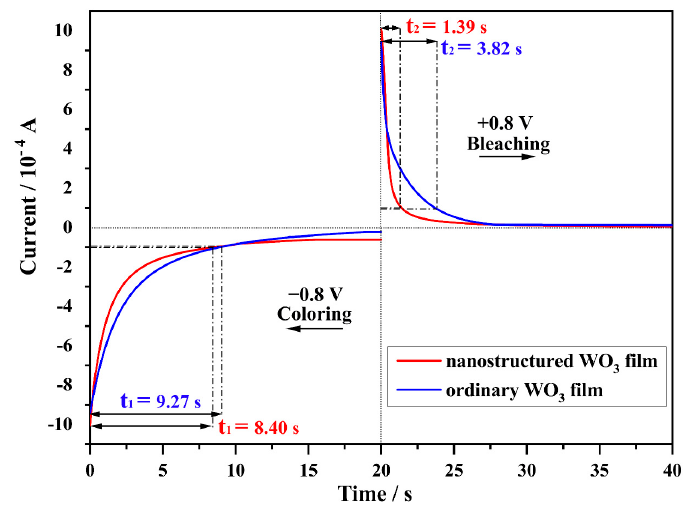
Figure 6. Response time of nanostructured WO 3 film and ordinary WO 3 film.